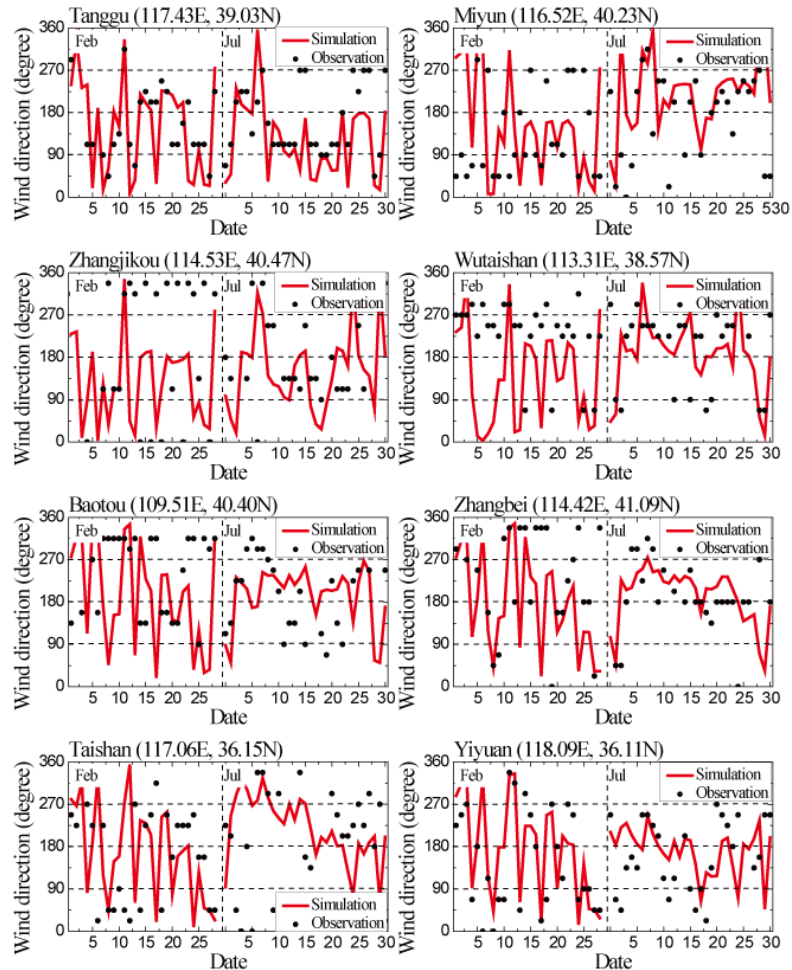
Figure 5. Same as Fig. 2 but for wind direction ( ◦